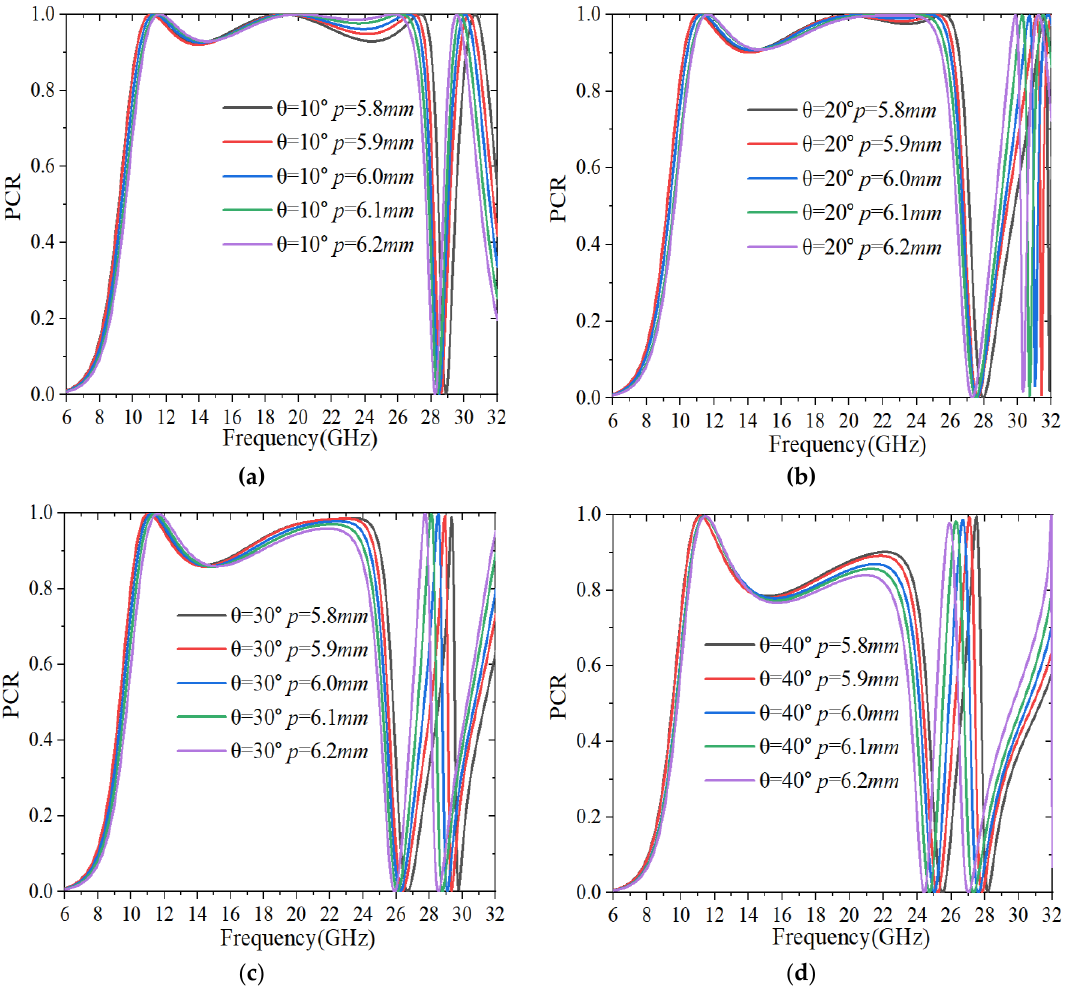
Figure 6. The amplitudes of xx r for normal x -polarization incidence. ( a ) θ = 1 0°; ( b ) θ = 2 0°; ( c ) θ = 30°; ( d ) θ = 4 0°.